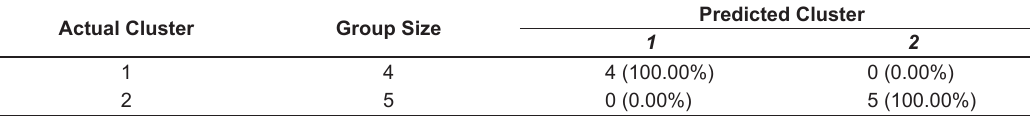
Percentage of cases correctly classified: 100.00%. Table 8. Classification Function Coefficients and Analysis of Variance. Variables: Factor 1 (Nitrates, Total-P, ST and SST), Factor 2 (Chlorophyll and BDOC), Factor 3 (Alkalinity and SD) and CO Significance with 95% confidence level = p-value, determination coefficient =R 2